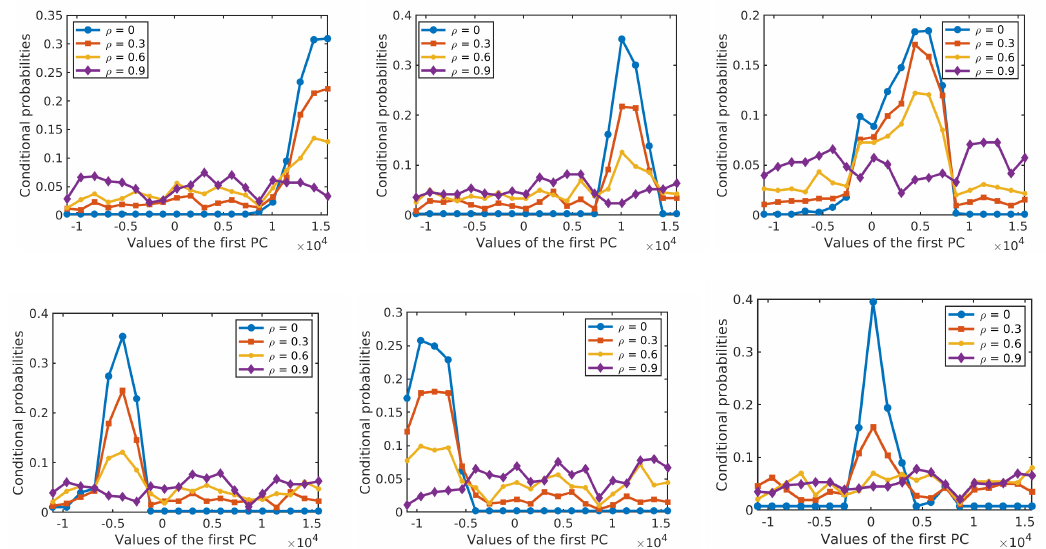
Figure 17. Conditional probabilities of the first PC for Class 1–6 (from the top left to bottom right) with different levels of label noise for the Salinas Scene data set.